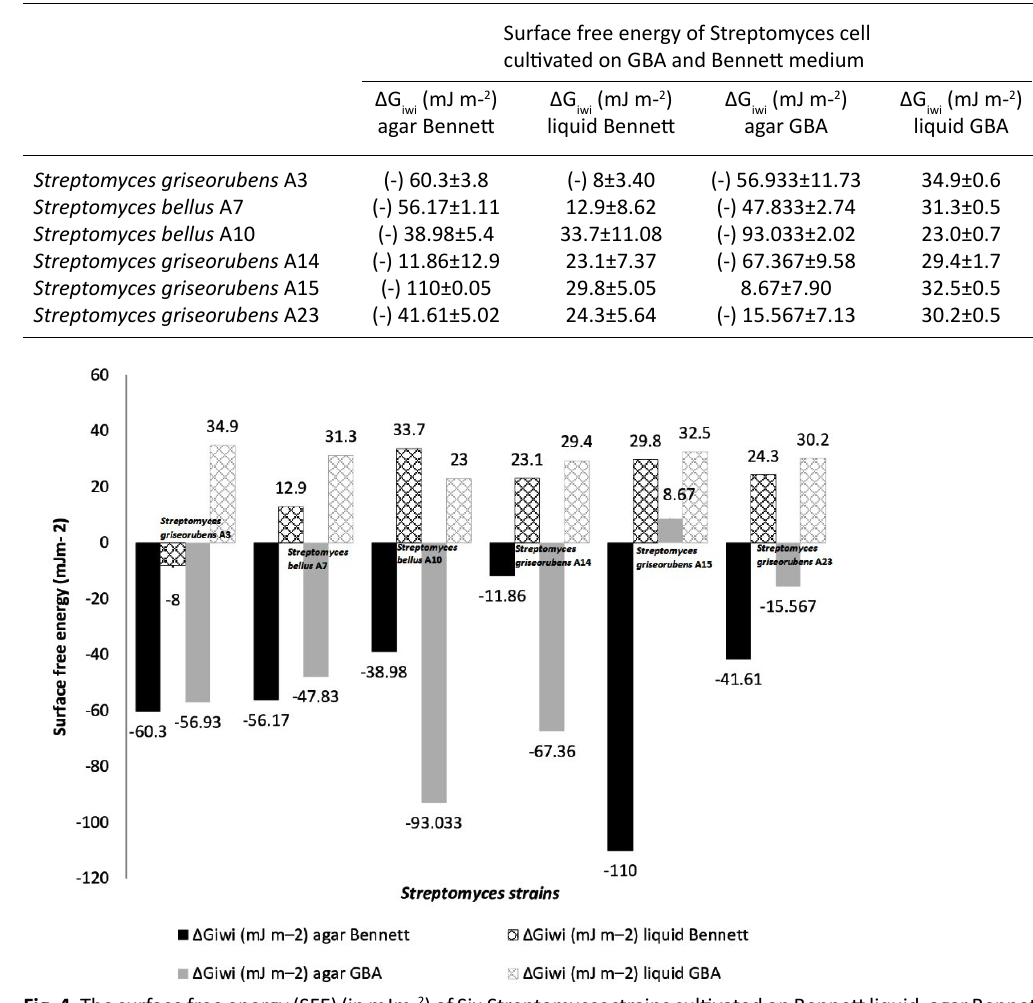
Fig. 4. The surface free energy (SFE) (in mJm- 2 ) of Six Streptomyces strains cultivated on Bennett liquid, agar Bennett, GBA liquid and agar GBA media.